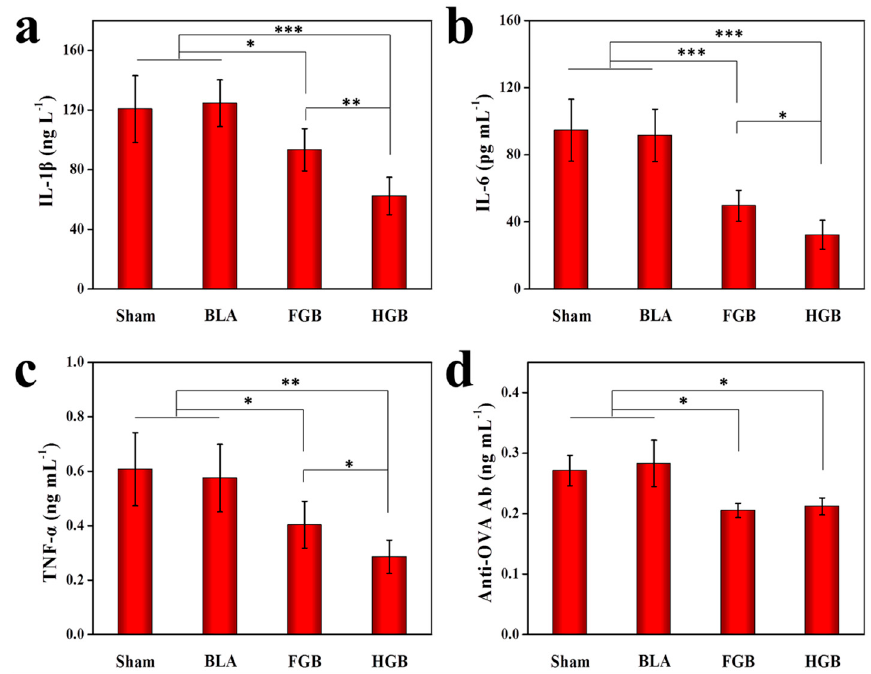
Figure 5. Concentrations of ( a ) IL-1 β , ( b ) IL-6, ( c ) TNF- α ( d ) anti-OVA Ab in serum determined by ELISA. The results are representative of means ± SD ( n = 5; * p < 0.05, ** p < 0.01, *** p < 0.001).